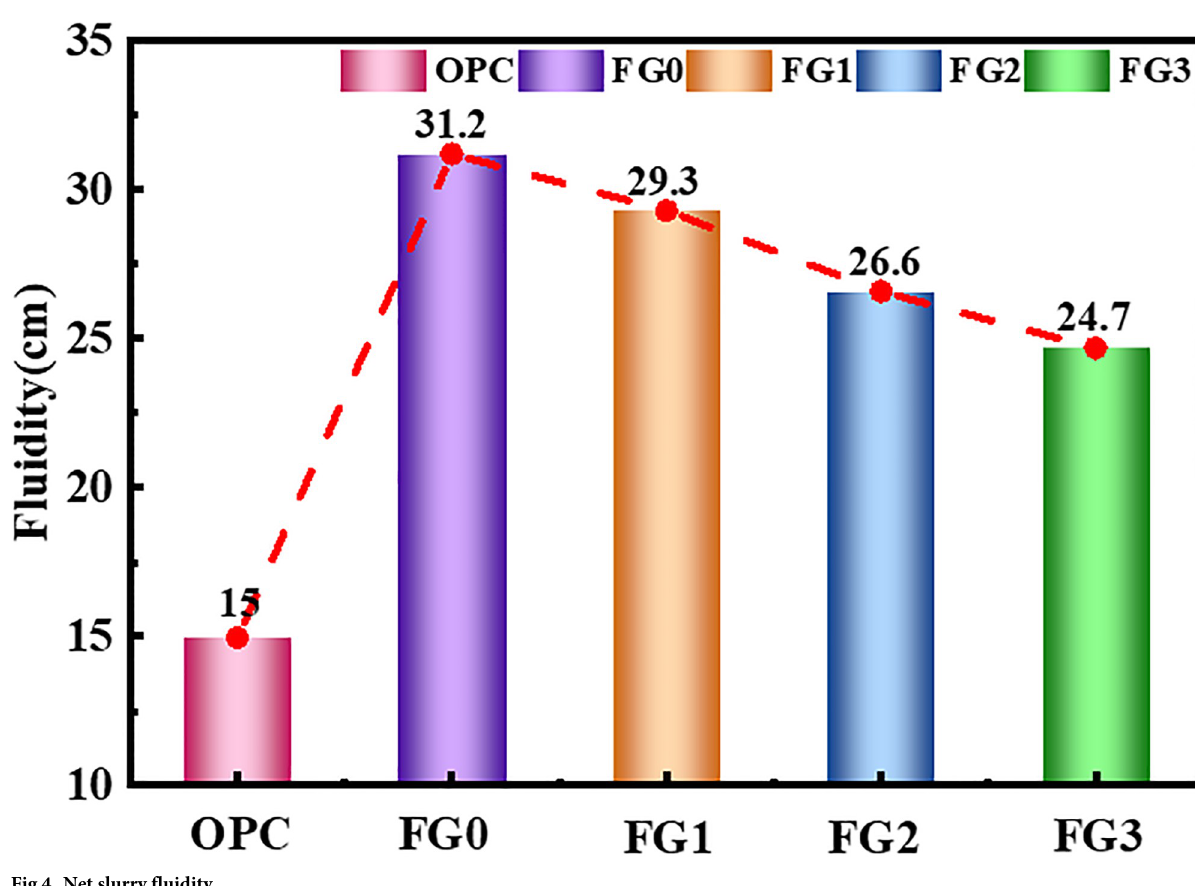
Fig 4. Net slurry